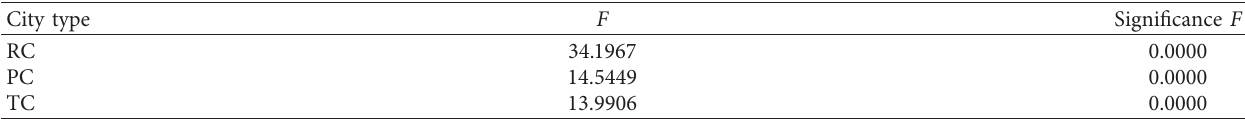
Table 5: Variance analysis.